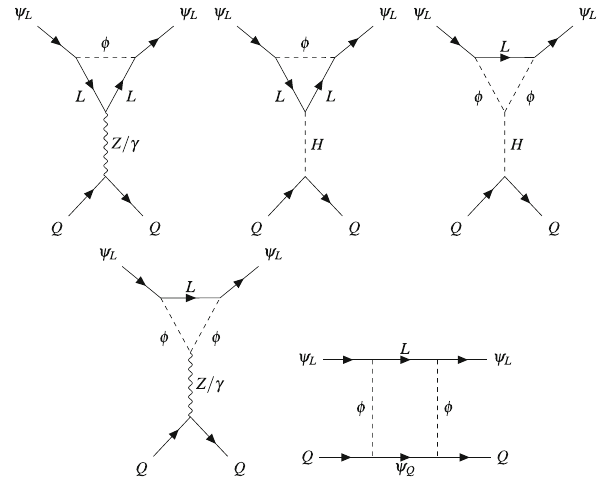
Fig. 5 LeadingorderDM-quarkdiagramscontributingtotheDDcross section of ψ L